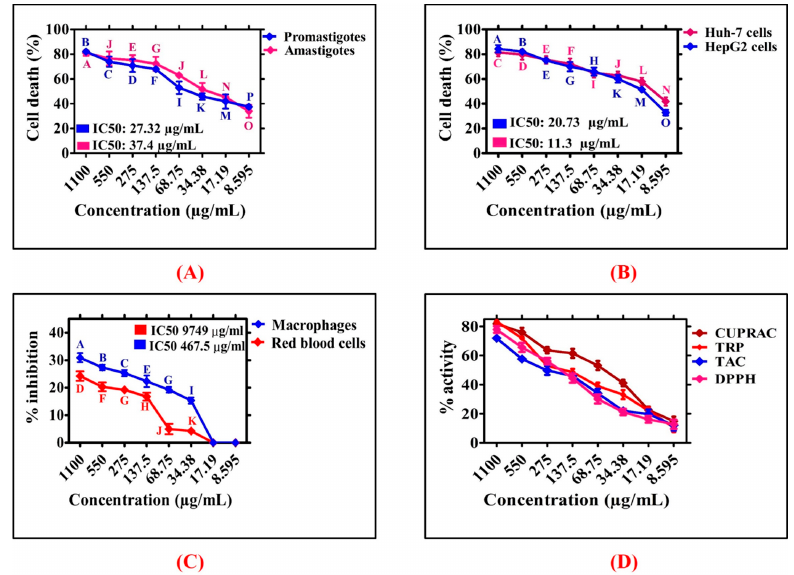
Figure 8. Biocompatibility, cytotoxic and antioxidant properties of NiONPs. Data represents the mean of three replicates and each alphabet indicates significance at p < 0.05 ( A ) Antileishmanial activities against Leishmanial parasites ( B ) Anticancer potentials of RT-NiONPs against HUH-7 and HepG2 cell lines ( C ) Biocompatibility of NiONPs against RBCs and Macrophages ( D ) Antioxidant activities of RT-NiONPs.